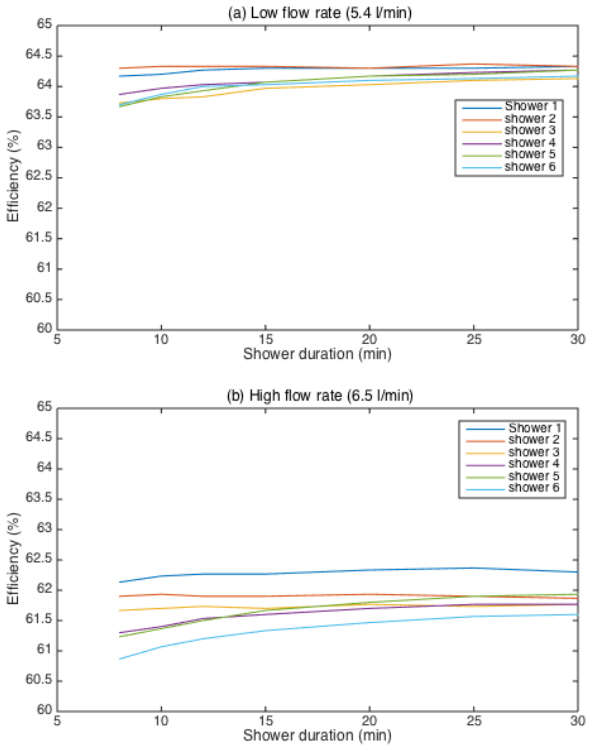
Figure 6. Energy recovery efficiency of each shower (average of three tests) in EXP